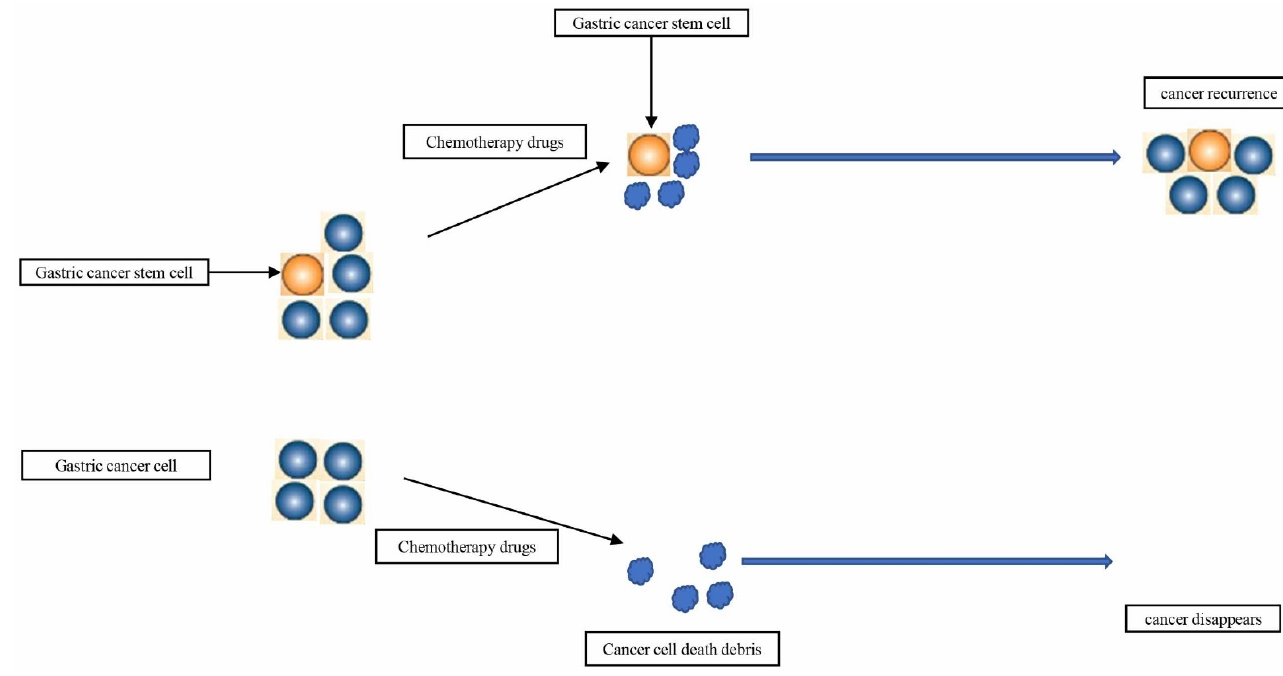
Figure 1. GCSCs are also considered to be a key factor in GC recurrence and chemotherapy re-